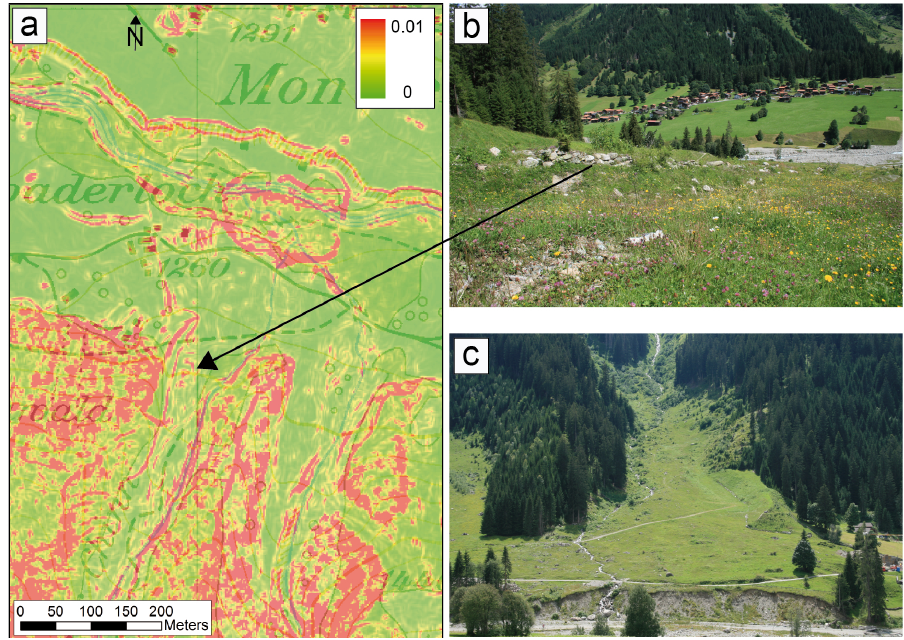
Fig. 4. Terrain features in the run-out zone. Panel (a) shows terrain roughness, as defined by Sappington et al. (2007), derived from a DTM with 2m grid resolution. Panel (b) shows rock deposits situated beside the dam. Panel (c) is a view of the run-out